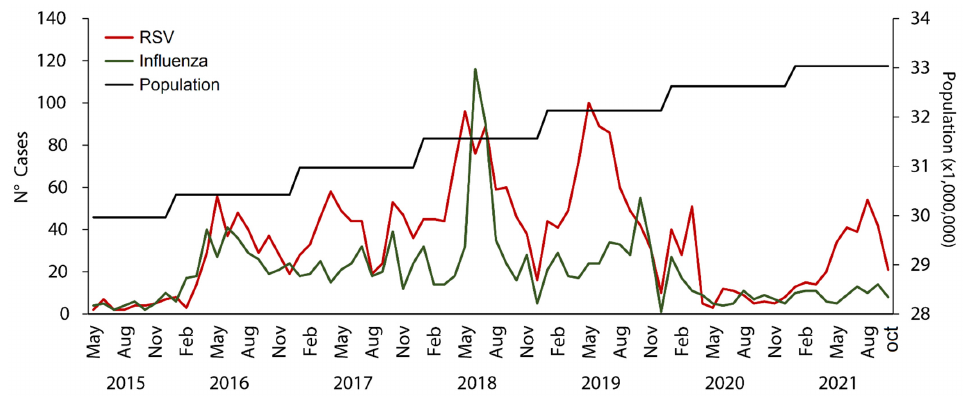
Figure 1. Monthly hospitalizations from the RSV and the influenza virus in Peru, seasons from 2015 to 2021.